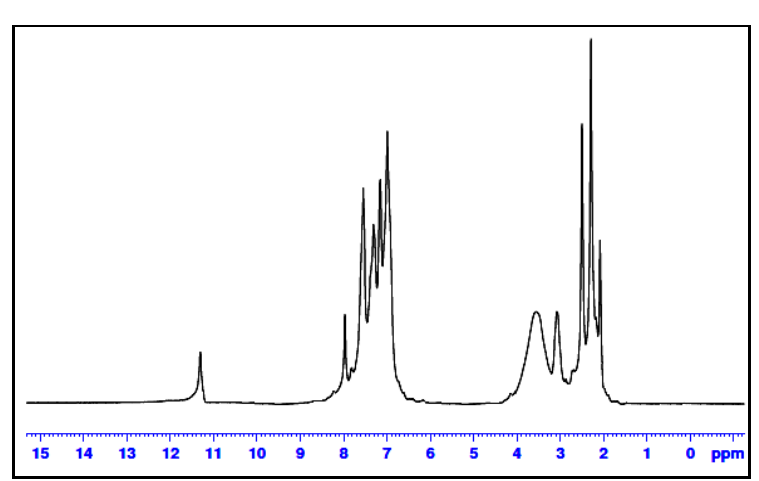
Figure 2. 1 H NMR spectrum of compound